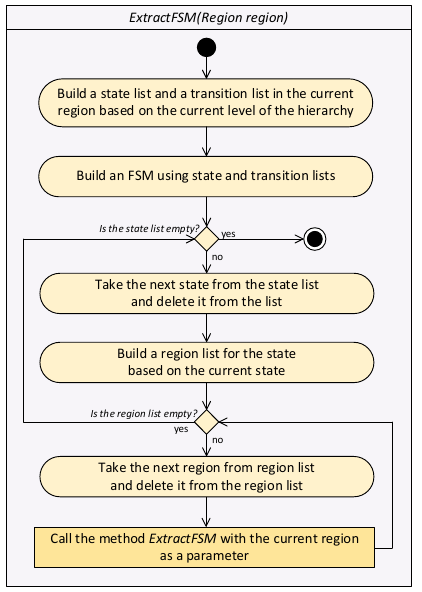
ExtractFSM(Region region)